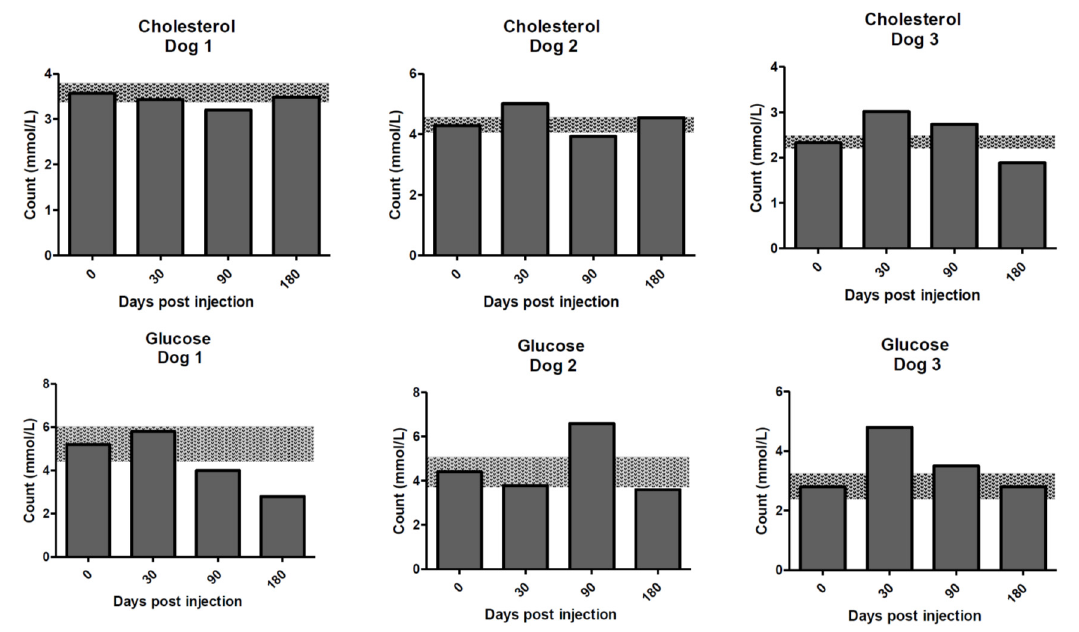
Figure 8. Cholesterol and glucose concentrations for the dogs on days 0–180 post treatment with 213 Bi-400-2 antibody. Upper row—cholesterol; lower row—glucose. Shaded areas show reference change values (RCVs).